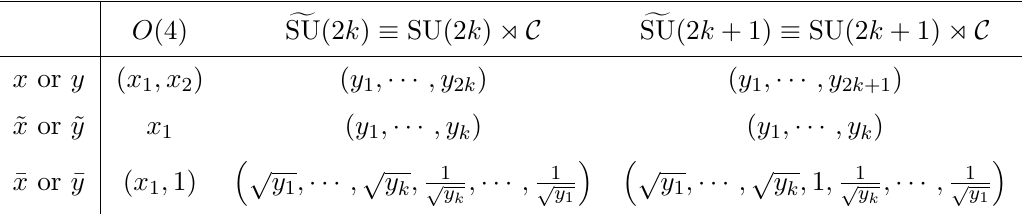
Table 5 . Relations among x , ˜ x , and ¯ x for O (4) , and y , ˜ y , and ¯ y for f SU( N f ) ≡ SU( N f ) o C . Note that our y variables for f SU( N f ) appear to have one more component than the rank of the group r = N f − 1 . This is because it is more convenient to use an ( r + 1) -dimensional vector space for the root and weight system of su ( r + 1) where all roots are orthogonal to the vector (1 , 1 , · · · , 1) . Consequently, a relation among the r +1 components of y is understood: Q r +1 ¯ y is obtained from y by relating components in accordance with folding the Dynkin diagram; see